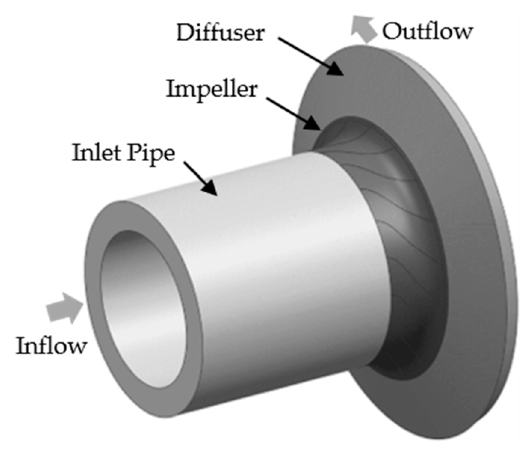
Figure 2. The fluid domain of MIX-130 fan.